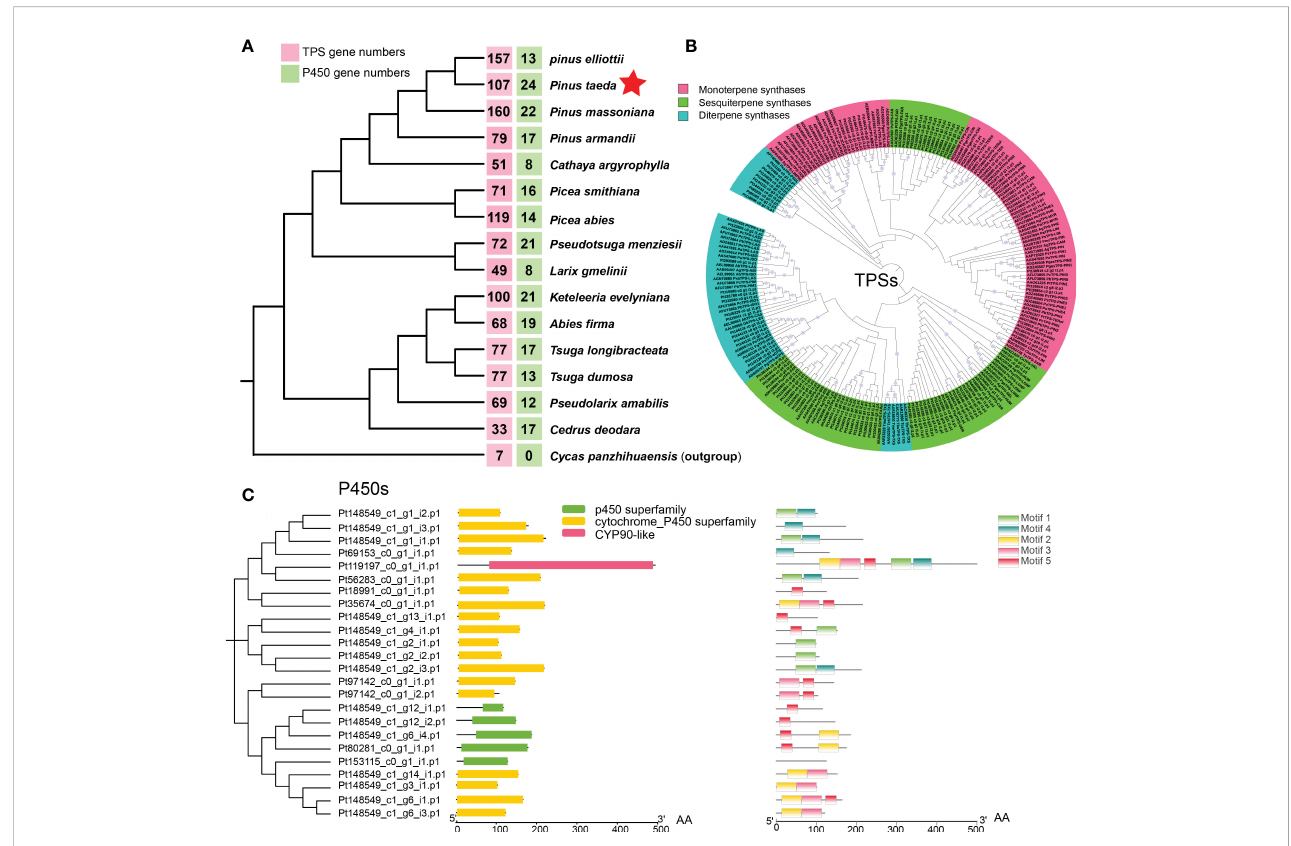
FIGURE 5 Evolution of the coniferous terpene synthase (TPS) family and P450 family. (A) The numbers of TPS genes (red box) and P450 genes (green box) in 16 gymnosperms (15 Pinaceae plants and 1 outgroup). (B) Maximum likelihood phylogenetic tree of terpene synthases (TPSs) in conifers. (C) Domain and motif of P450s in Pinus taeda amino acid